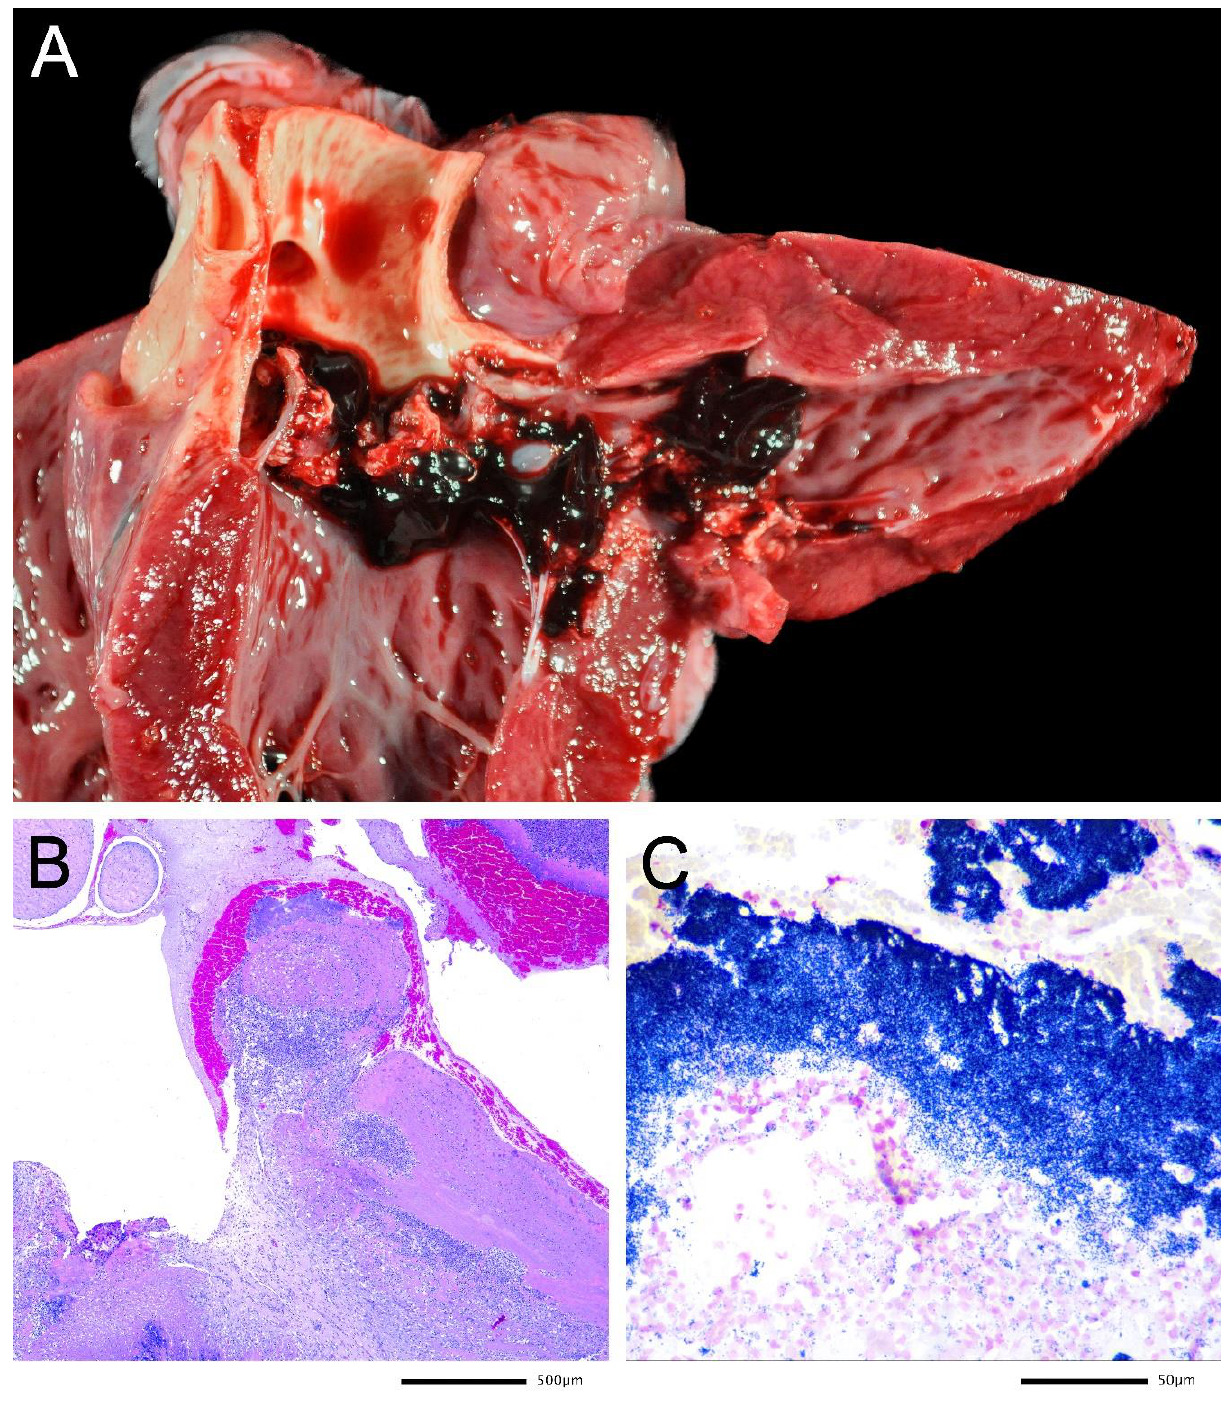
Figure 1. Pyrenean chamois heart from which Streptococcus ruminantium was isolated, strain CCGMV935. ( A ) Vegetative endocarditis of the left atrioventricular valve in a chamois ( Rupicapra pyrenaica ) caused by S. ruminantium . ( B ) H&E staining shows that the valve leaflet is expanded by fibrin, inflammatory cells, and numerous bacterial colonies. ( C ) Gram staining showing coccus-shaped Gram-positive (dark blue) bacteria in the vegetation. In the case of the domestic sheep, where S. ruminantium CCGMV928 was isolated from, multiple white to yellowish nodular suppurative lesions of 0.5 to 2 cm in diameter were detected in the liver (Figure 2A,B). These lesions were randomly distributed on the surface and throughout the parenchyma. Adjacent lymph nodes appeared to increase in size but without evident macroscopic lesions. Additionally, there were consolidation and reddening of cranio-ventral lung lobes consistent with suppurative bronchopneumonia and multifocal areas of grey to whitish discoloration and consolidation in caudo-dorsal lobes consistent with verminous pneumonia. At histology, multiple extensive abscesses